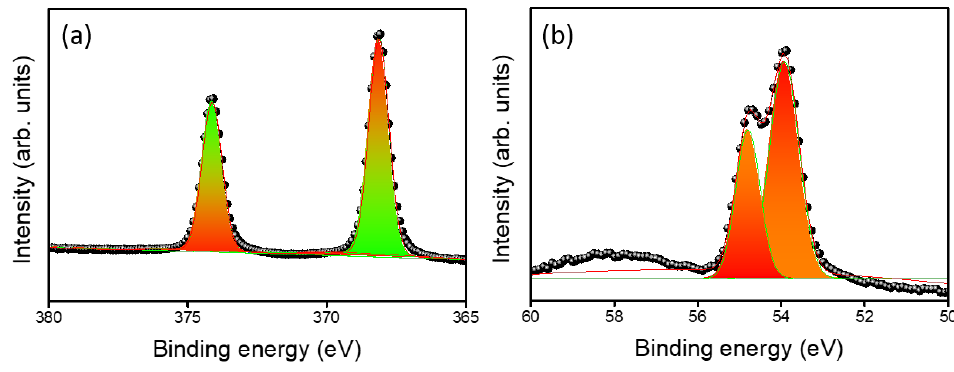
Figure 4. XPS spectra of Ag 2 Se-200 ( a ) Ag 3d and ( b ) Se 2p atom.